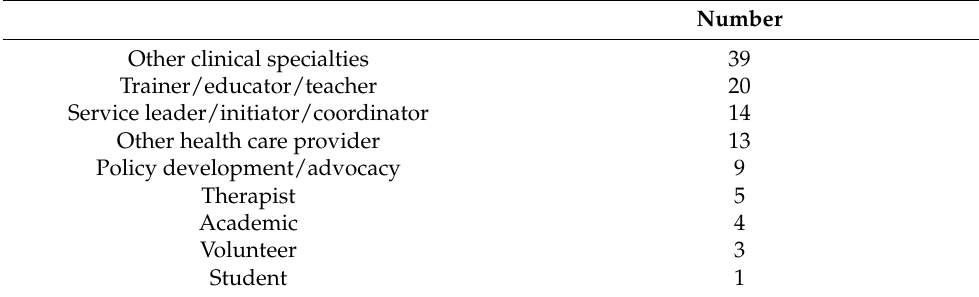
Table 5. Other occupations Q10 (free text responses).